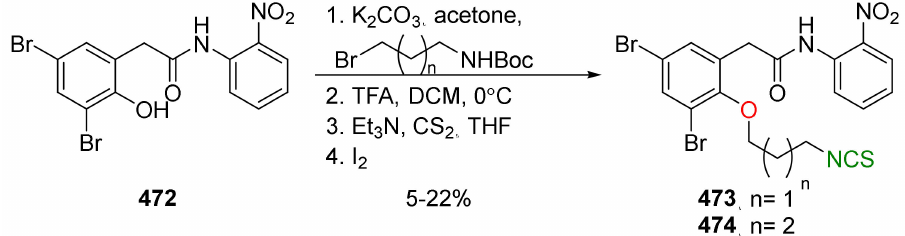
Figure 54. Synthesis of ether-linked isothiocyanate analogues 473 and 474